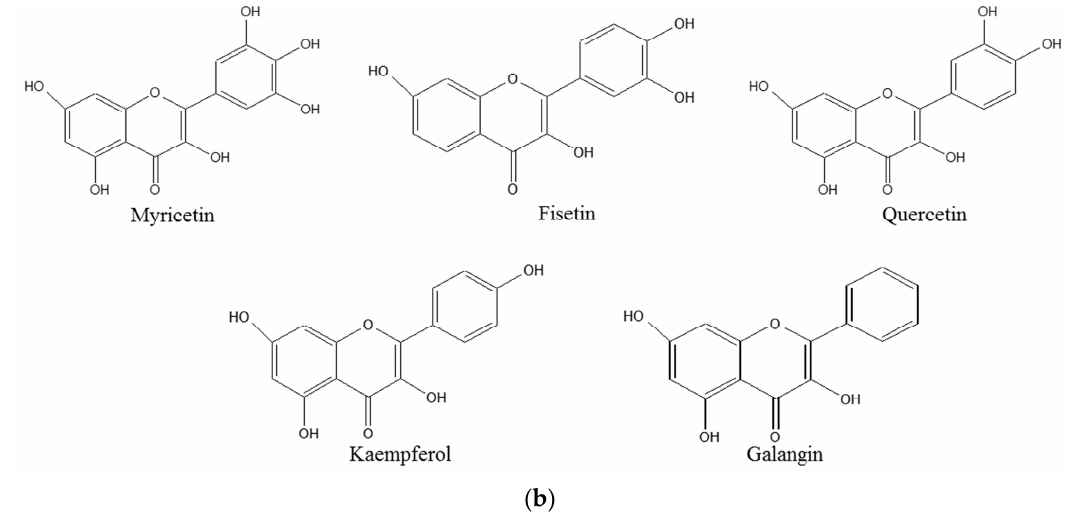
Figure 1. ( a ) Basic flavonoid structure showing the A and B rings and the conventional numbering of carbon atoms and ( b ) structure of various flavonoids used in this study.